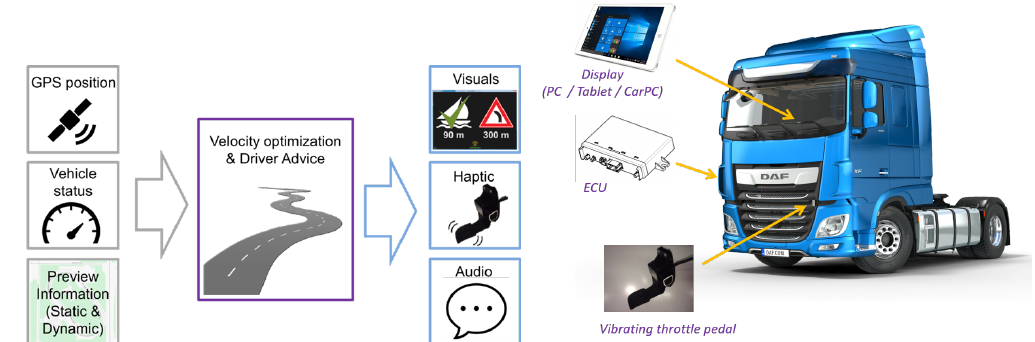
Figure 1. Schematic of the predictive driver coaching (PDC) system.